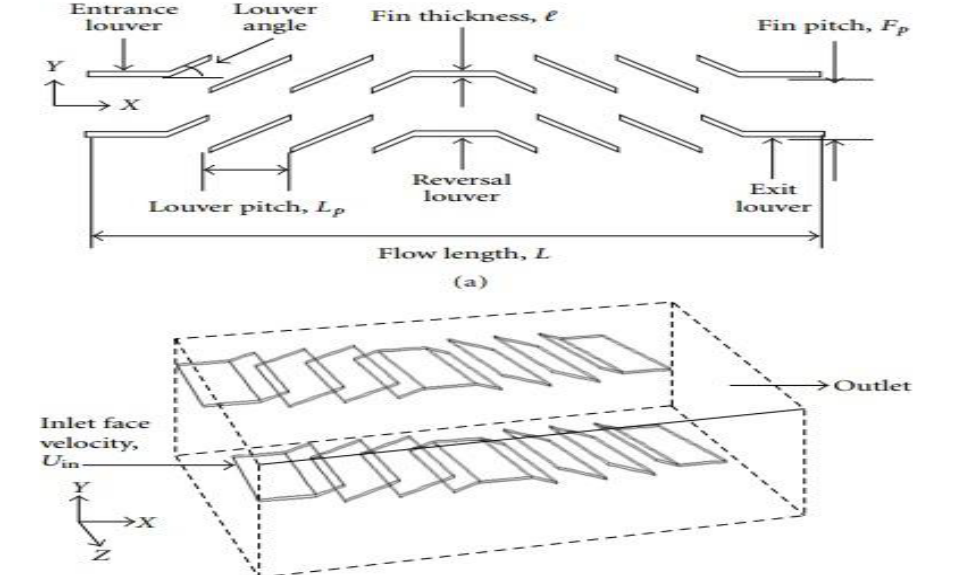
Figure 17: (a) The physical model (2D view in X-Y plane) and (b) computational domain